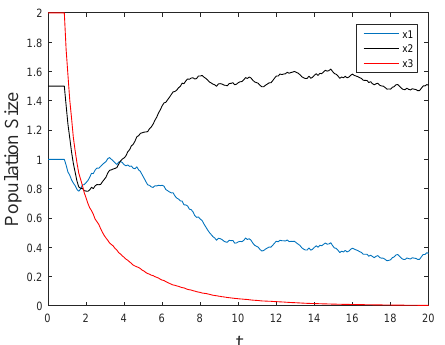
Figure 3. Other data are the same as in Case 2, and the intensity of white noise is